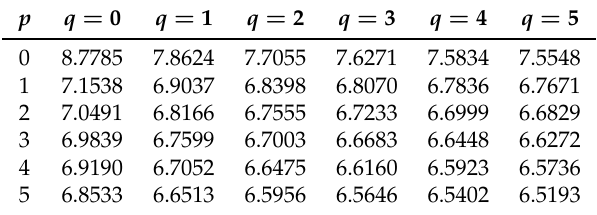
Table A4. Conditional entropies H ( p , q ) (bits/pixels), computed for various values of p and q , over “Scene-1”.